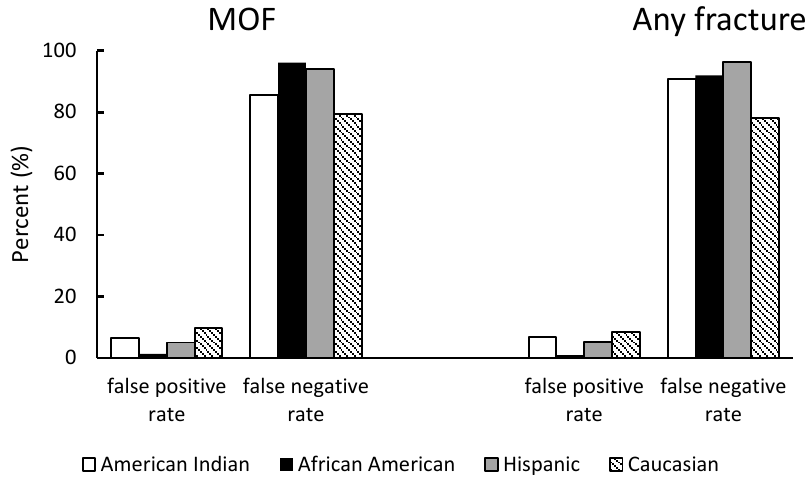
Figure A4. False-positive rate and false-negative rate for major osteoporotic fracture and any fracture in the analytic sample by race.